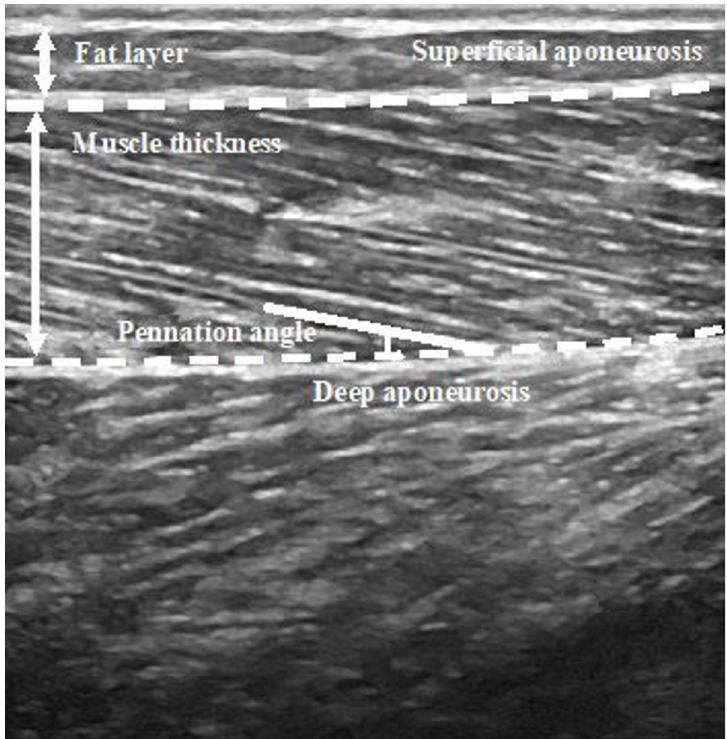
Fig 1. Example of fascicle tracking on an ultrasound image. Muscle thickness was calculated as the distance between the deep and superficial aponeurosis. Pennation angle was calculated as the angle between the deep aponeurosis and the tracked